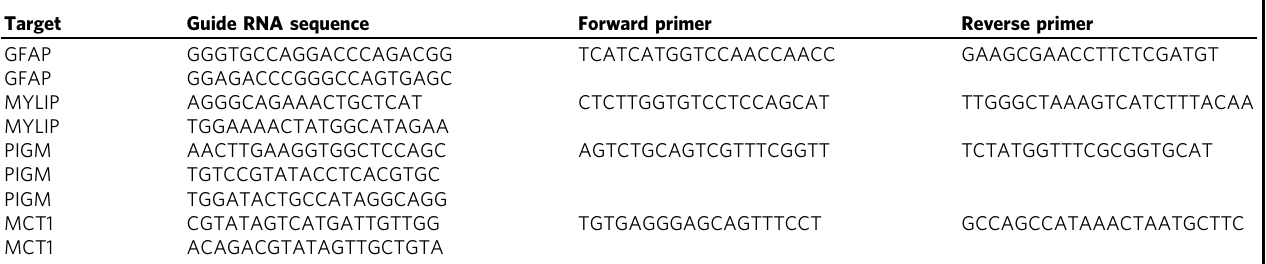
Table 1 sgRNA and primer sequences used to demonstrate editing ef fi